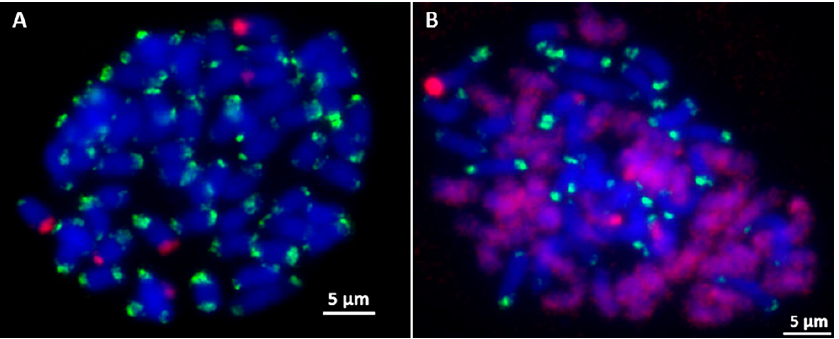
Figure 5. FISH result of clone Ea009 and 45S rDNA. ( A ) HN92-77; ( B ) YCE96-40. The probe of clone Ea009 was labelled with Dig (Green), the probes of both 45S rDNA and Badila gDNA were labelled with Biotin (Red), chromosomes were counterstained with DAPI (Blue). Scale bars = 5 μ m.